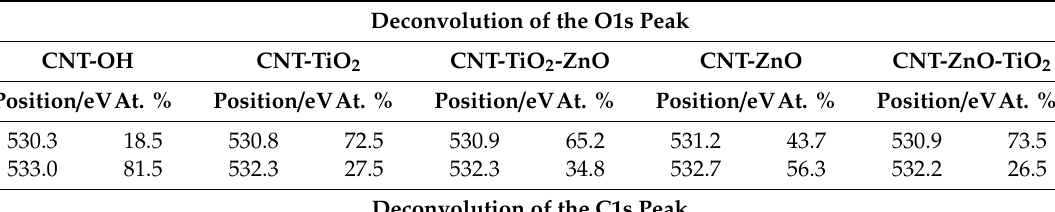
Table 3. Deconvolutions of the O1s and the C1s peaks from XPS